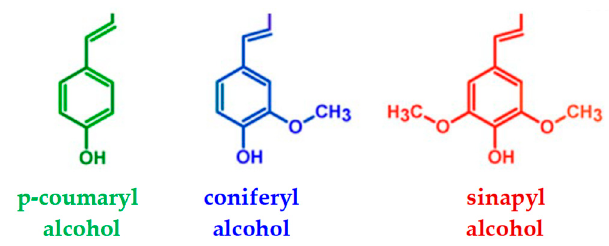
Figure 1. Basic phenol units.